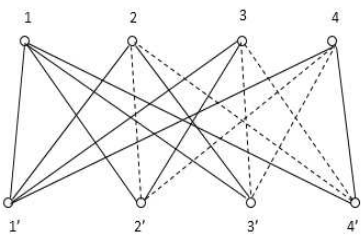
Figure 1. The signed bipartite graph B ( U 1 , V 1 )